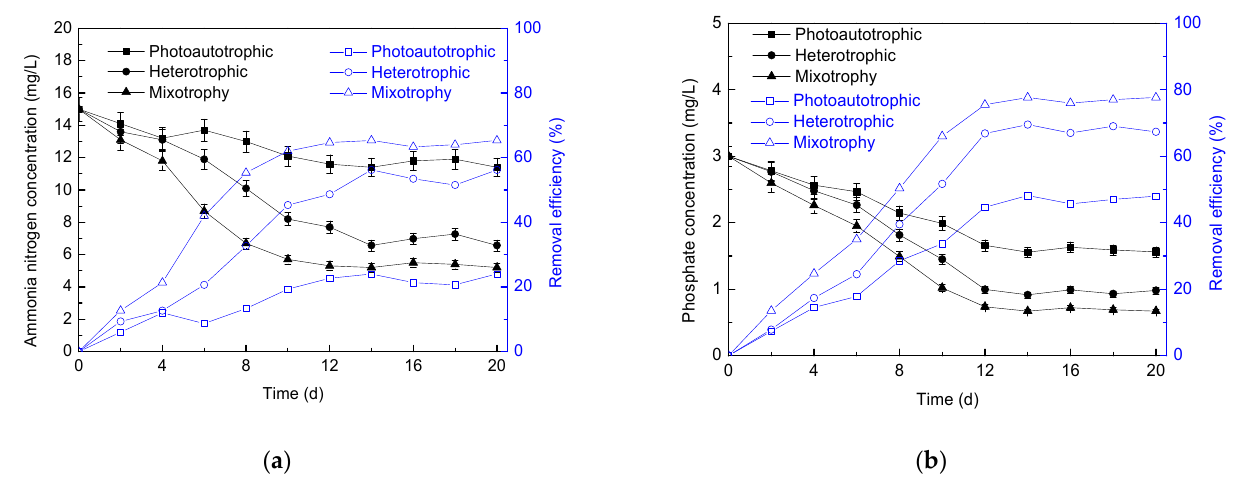
Figure 3. Influence of different culture modes on ammonia nitrogen ( a ) and phosphorus ( b )